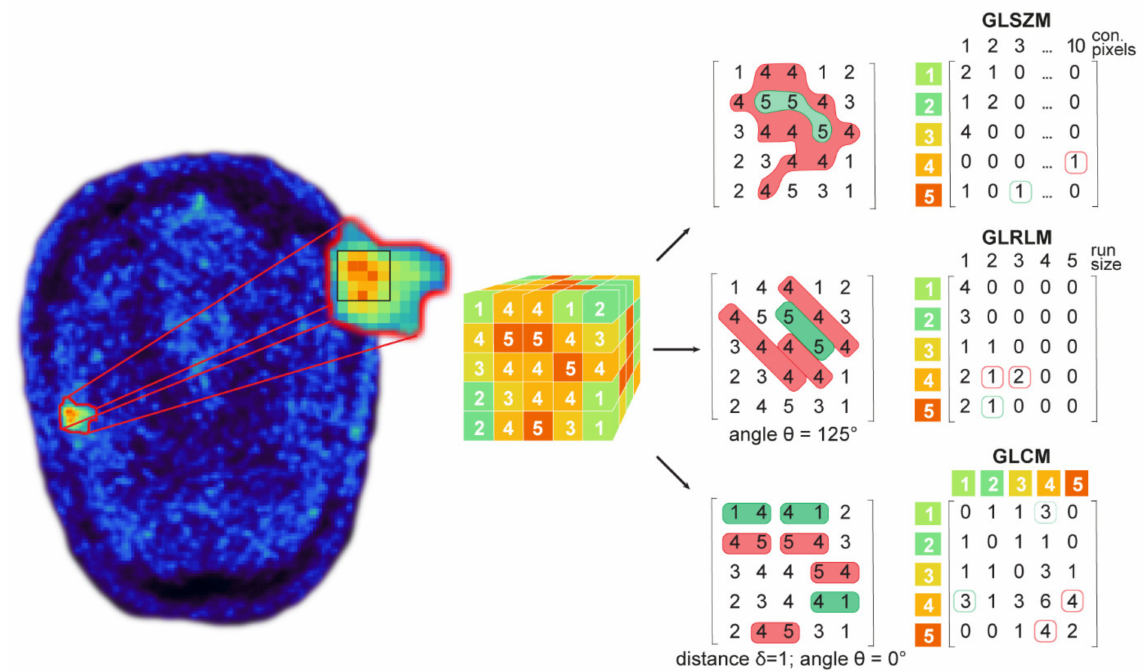
Figure 2. The calculation of textural features based on gray level matrices. Textural features are usually calculated on a previously segmented tumor and grouped based on the gray level matrices from which they are extracted. Features calculated from the gray level size zone matrix (GLSZM) represent connected gray level values and their associated zones or areas. The gray level run length matrix (GLRLM) represents consecutive voxels with the same intensity. The gray level co-occurrence matrix (GLCM) represents voxel pairs’ frequency of occurrences of the same